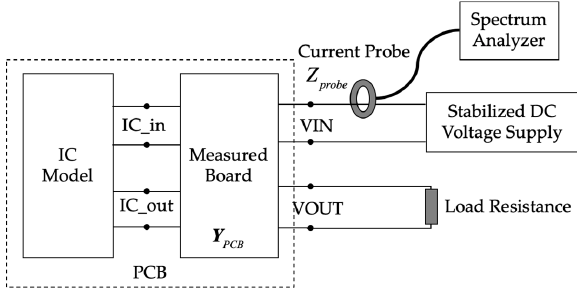
Figure 10. The block diagram of the measurement setup.